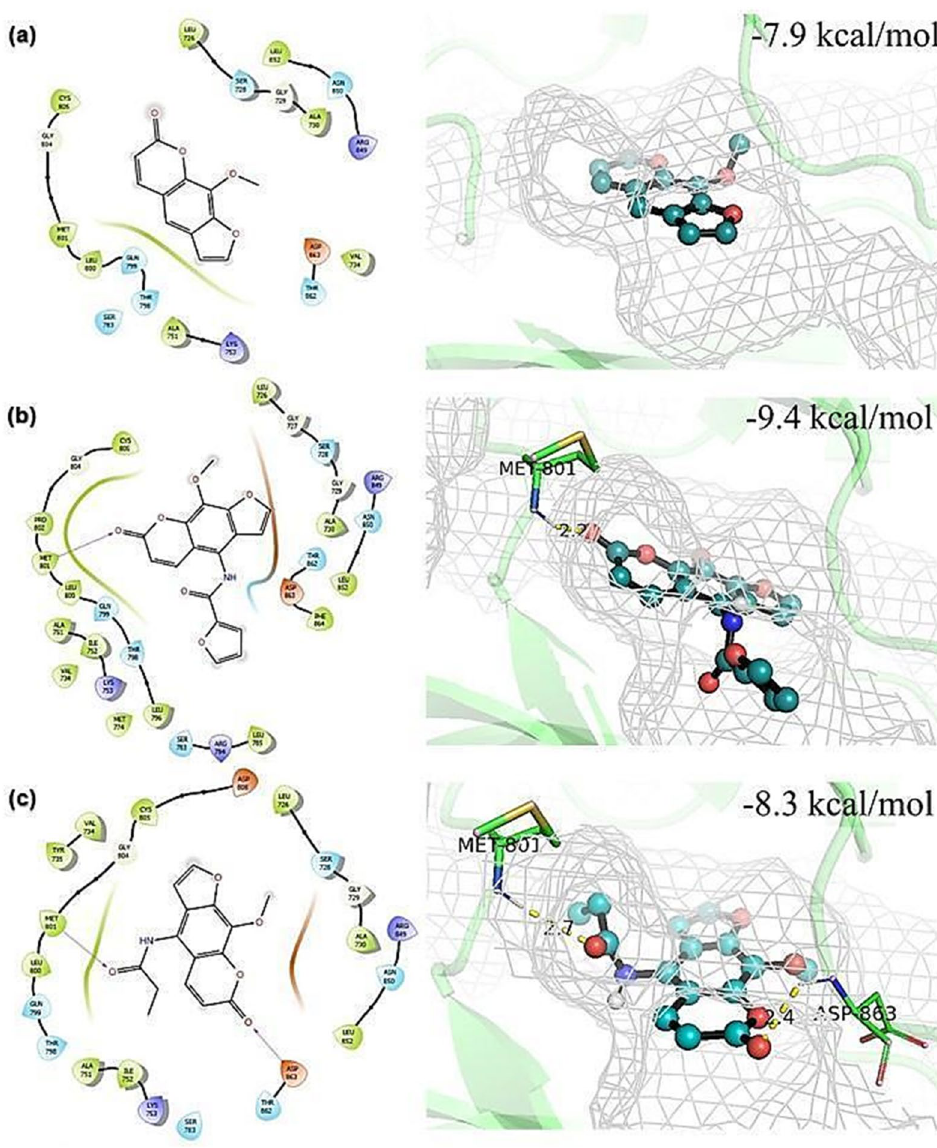
Figure 4. 2D and 3D representations of top-scoring poses obtained from molecular docking models between psoralen derivatives: 8-MOP ( a ), 3g ( b ), or 3j ( c ) and HER2 (PDB code: 3PP0) 44,45 . The purple arrows represent the hydrogen bonding. Ligand molecules shown as ball and stick models are colored cyan (carbon), red (oxygen), blue (nitrogen), and white (polar hydrogen). Hydrogen bonding is shown in yellow dashed lines to amino acid residues, and the distance (Å) between atoms of amino acids and ligand is